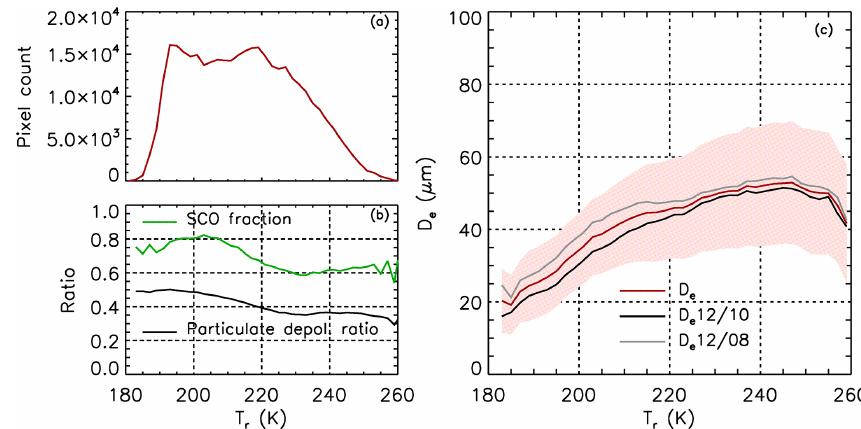
Figure 9. IIR V4 confident retrievals vs. radiative temperature in semi-transparent ice clouds over oceans between 60 ◦ S and 60 ◦ N in January 2008. (a) Pixel count; (b) fraction of retrievals using the SCO model (green) and mean CALIOP integrated particulate depolarization ratio (black); (c) mean D e (red) ± mean absolute deviation (shaded area), mean D e 12 / 10 (black) and mean D e 12 / 08 (gray).